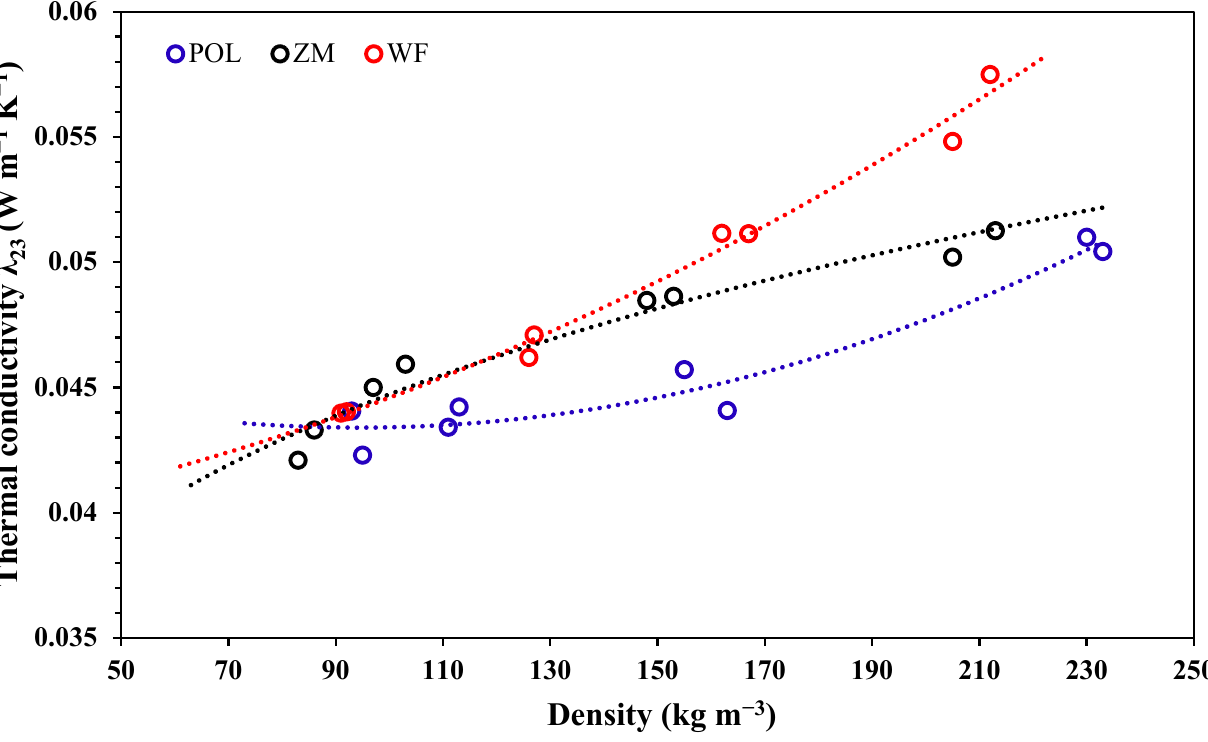
Figure 2. Thermal conductivity of seagrass-based boards (POL and ZM) and wood fiber-based boards (WF) at 23 °C for actual densities varying from 80 to 228 kg m − 3 .